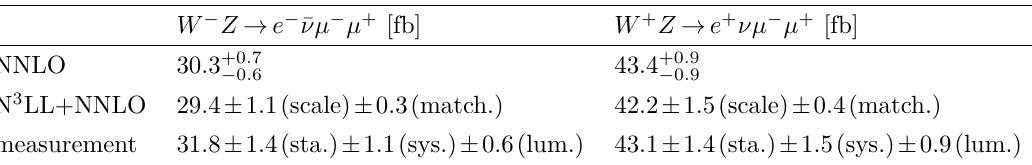
Figure 7 . Comparison of NNLO and N 3 LL+NNLO predictions for the truth m W ± Z using the CMS cuts in table 5.